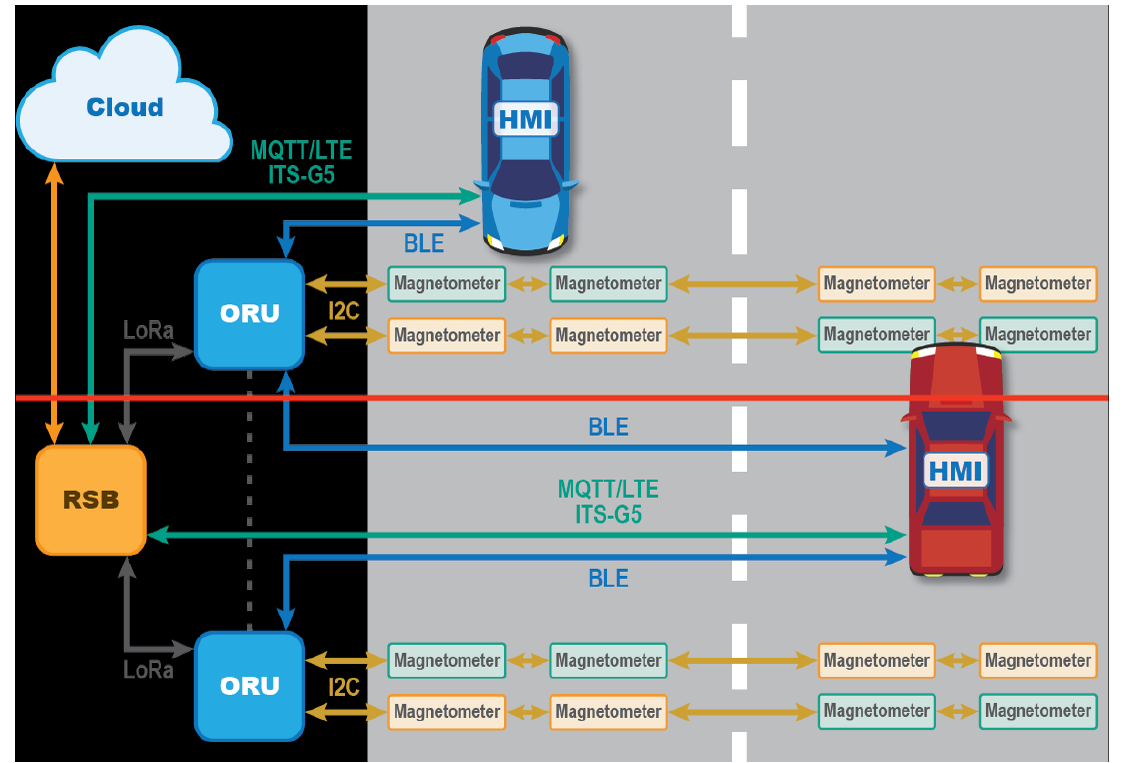
Figure 1. ODOS2020 system architecture.